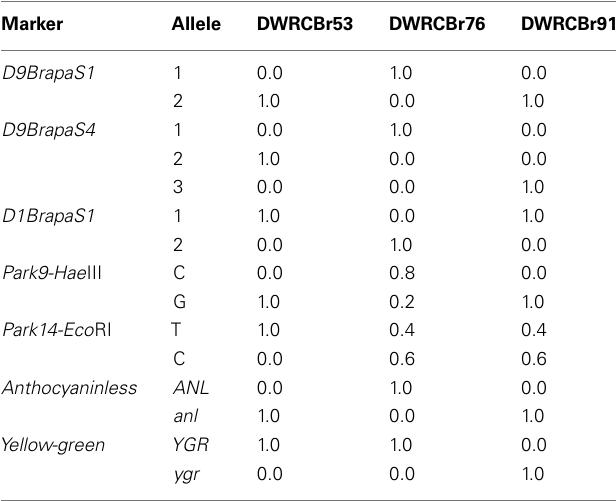
Table 5 | New RCBr strains with defined marker genotypes.